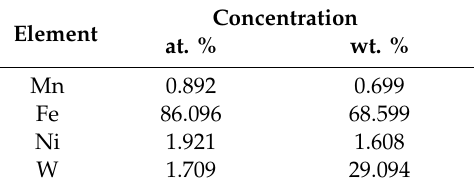
Table 8. The elemental composition of the carbide coating matrix (2—Figure 9). Concentration Element at. % wt. %